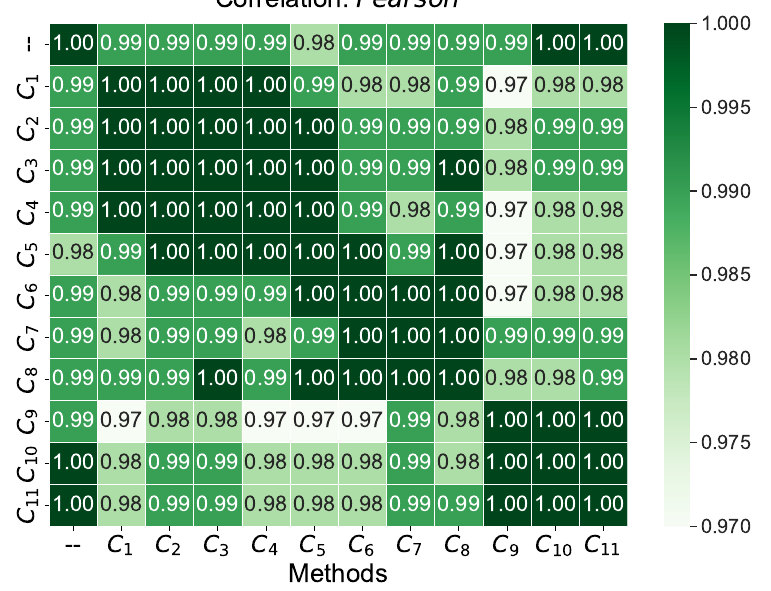
Figure 4. Pearson correlation coefficient values between scores obtained from modified C 1 – C 11 criteria values by a threshold value of α = 0.05 (darker colors mean a higher correlation